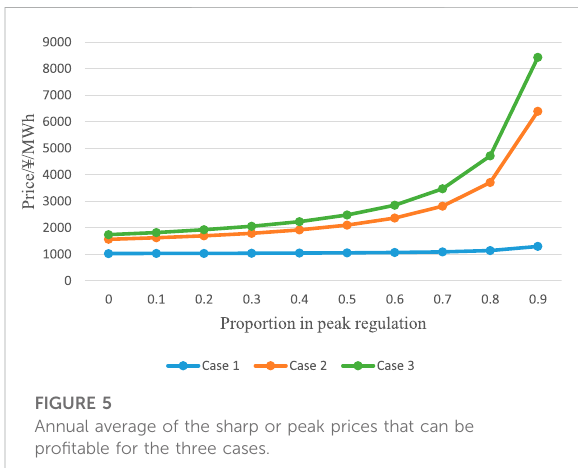
FIGURE 5 Annual average of the sharp or peak prices that can be pro fi table for the three